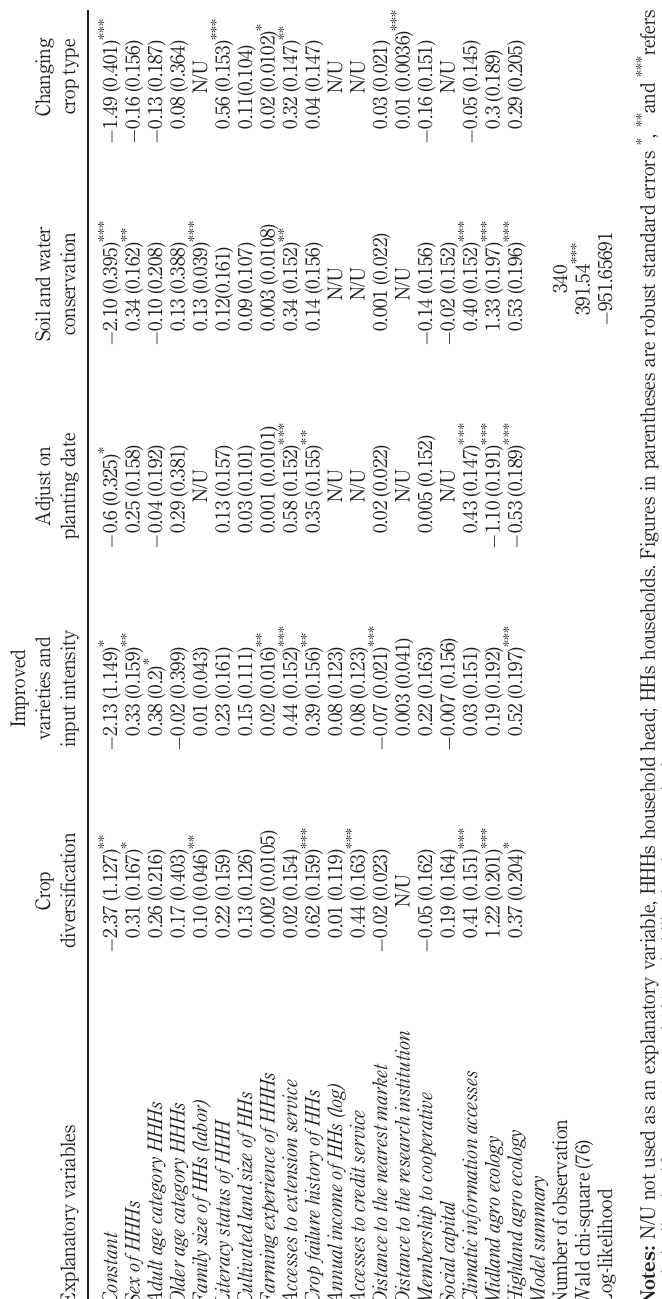
Table 5. Parameter estimates from multivariate probit for estimating factors affecting farmer ’ s choice of adaptation strategies to climate